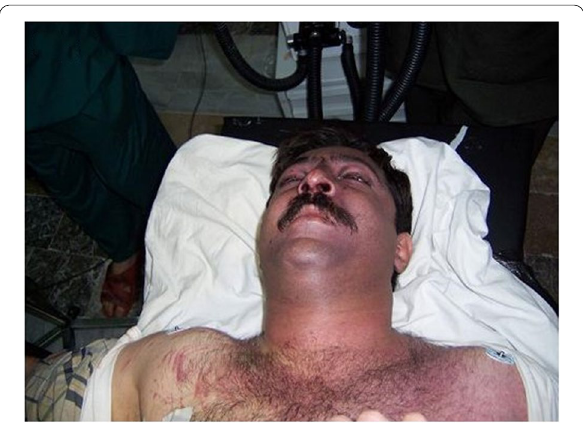
Fig. 1 Bluish to violet cyanotic discoloration of the face, neck, and upper chest in case 1